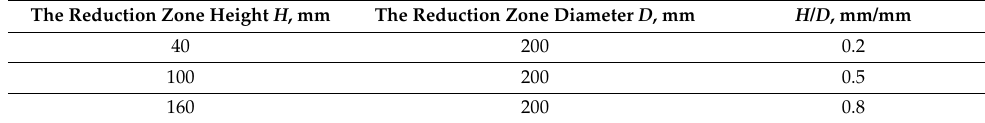
Table 1. The reduction zone